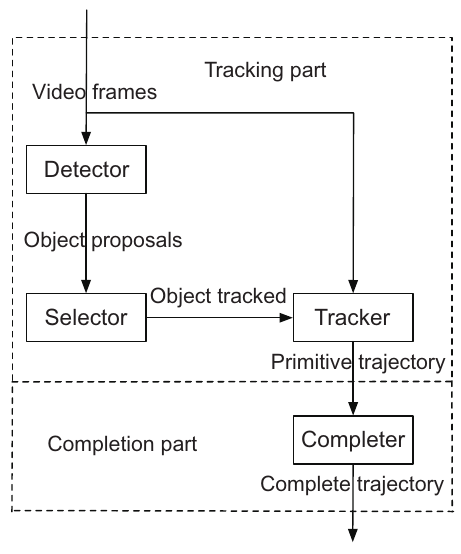
Fig. 1 Data flow between the components of